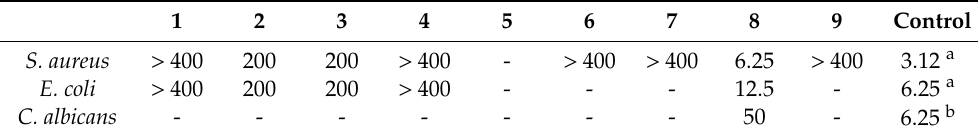
Table 5. Antimicrobial Activity of Compounds 1 – 9 (MIC µ g /